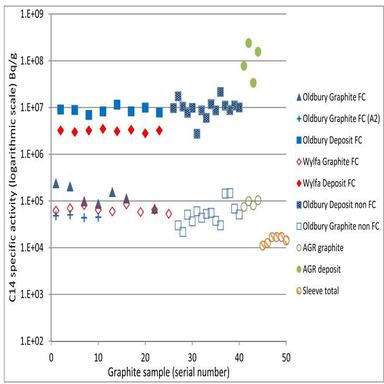
C-14 specific activity in the AGR core graphite and carbonaceous deposits and in graphite sleeve samples. The results are combined with the Magnox core graphite data from (19) for comparison.